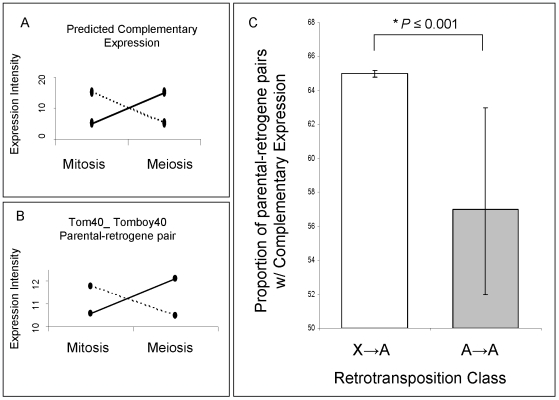
Parental gene and retrogene expression analysis.(A) Predicted complementary expression in meiosis is defined as under-expressed parental gene (dotted line) and over-expressed retrogene (solid line). (B) Empirical complementary expression pattern of the parental gene Tom40 and the retrogene Tomboy40 retroposed from X chromosome to autosome (Figure 6A and Table S2—pair 18) [10]. A and B vertical axes represent the gene expression intensities in log2, whereas the horizontal axes indicate spermatogenic phases. (C) Proportions and Bayesian 95% Confidence Intervals of parental-retrogene pairs satisfying complementary expression in meiosis: X→A pairs (white box), A→A pairs (grey box). *Bayesian P≤0.001.